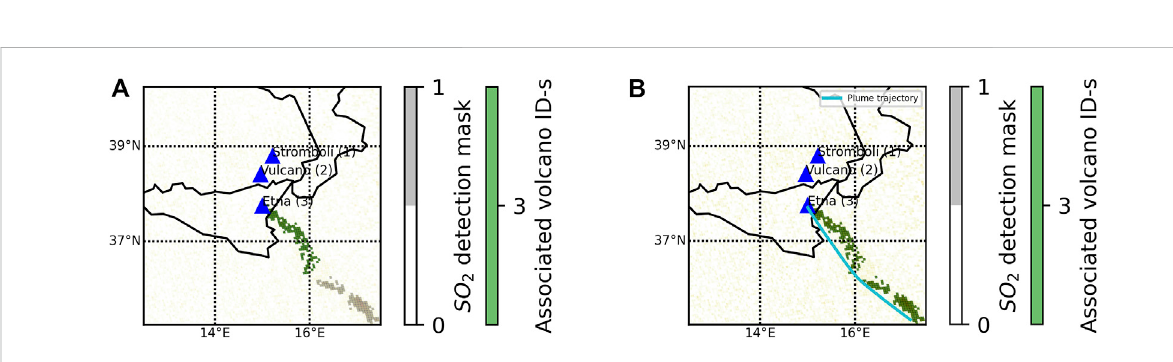
FIGURE 8 Difference in binary DBSCAN classi fi cations (Etna volcano, on 17.06.2021). (A) Without wind. (B) With